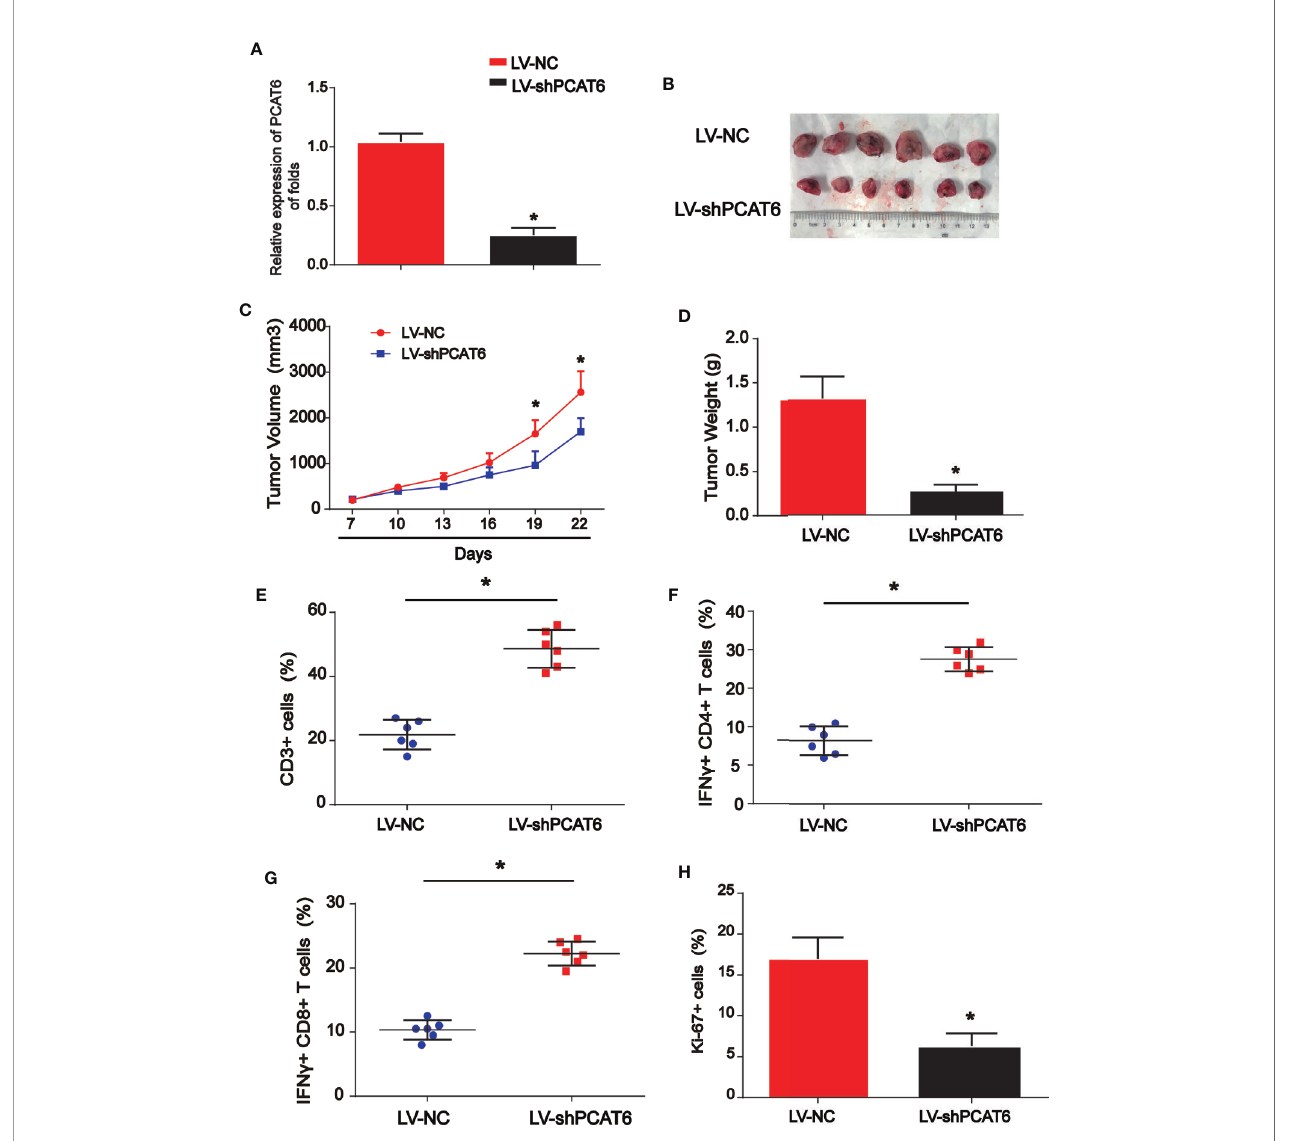
FIGURE 2 | The down-regulation of PCAT6s activated the immune response in vivo . (A) The ef fi ciency PCAT6 short hairpin RNA (shRNA) was con fi rmed using qRT- PCR analysis. (B) Nude mice with or without PCAT6 shRNA infected naïve CD8 + T cells incubated with CCA antigen-loaded DCs were injected with HuCCT1 cells. (C) Tumor growth curve. (D) Tumor weight. (E) Tumor sections were analyzed by IHC using CD3 antibody. (F, G) The frequencies of IFN- g -producing CD4+ or CD8 + T cells in tumors of both groups were determined by fl ow cytometry analysis. (H) The tumor sections were analyzed by immunohistochemistry. *P < 0.05. Compared with the control